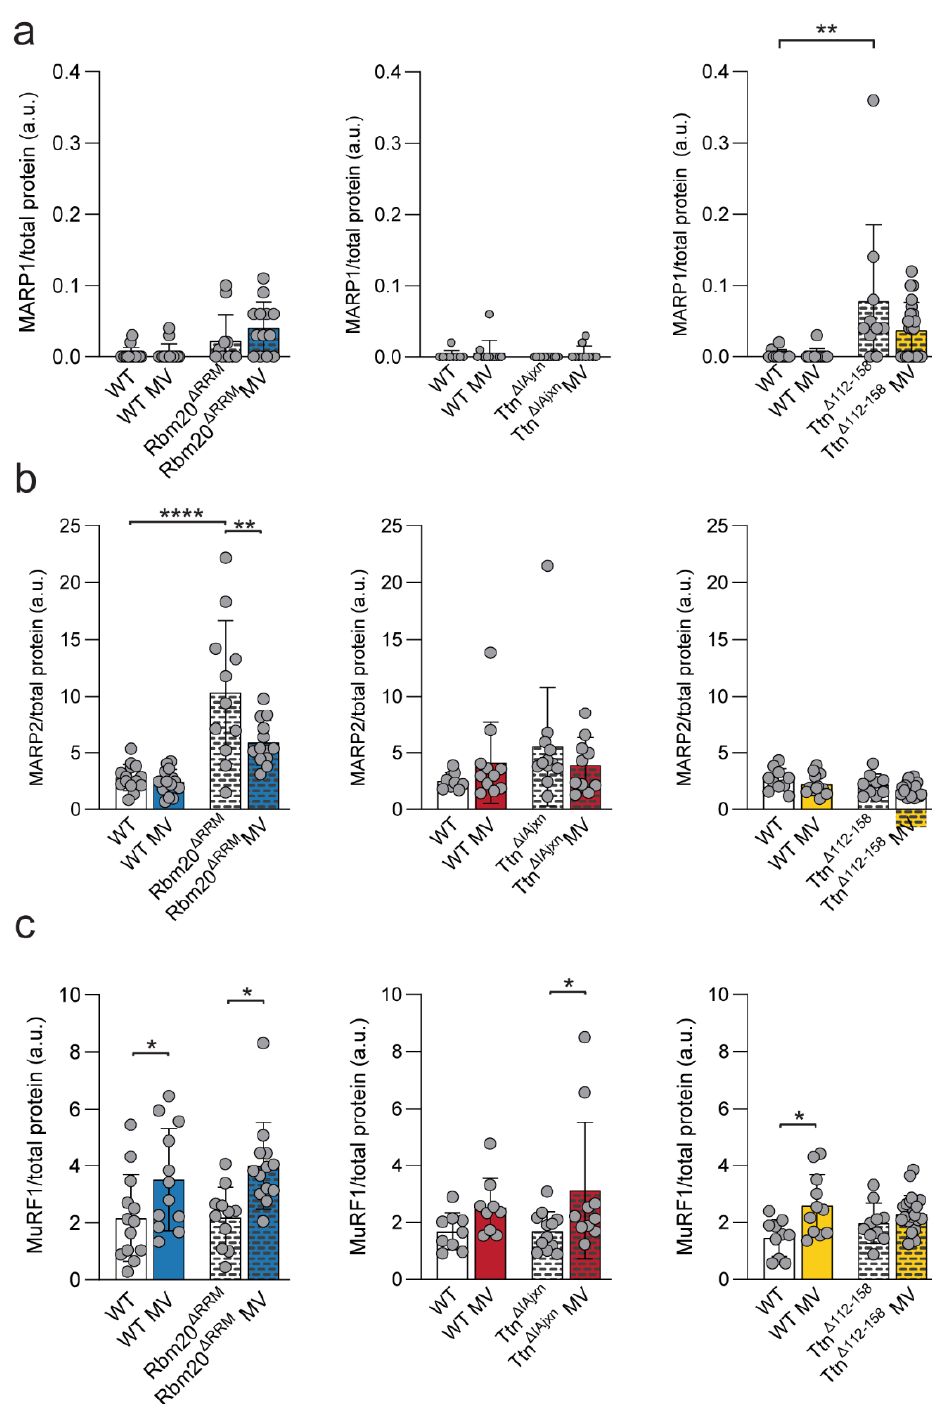
Figure 5. Protein expression levels of MARP1, 2 and MuRF1. ( a – c ) MARP1, MARP2, MuRF1 pro- tein expression relative to total protein in Rbm20 Δ RRM , Ttn Δ IAjxn and Ttn Δ 112 − 158 mice respectively. Bars represent mean ± SD. * p < 0.05, ** p < 0.01, **** p < 0.0001. WT = wild type, MV = mechanically ventilated. Each dot represents a single animal and animals are only presented in each graph once.